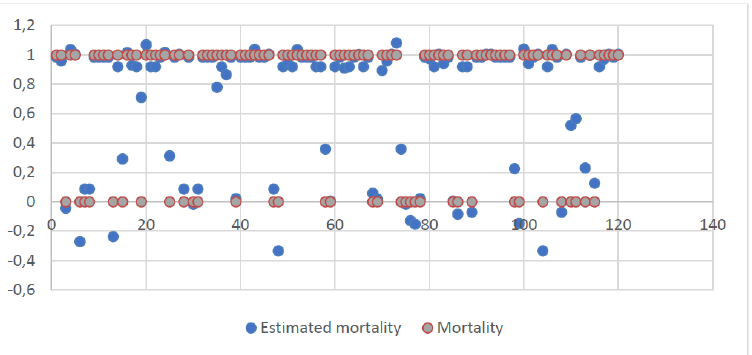
Figure 1. Results of linear regression between frailty criteria at recovery and after 2 years, and type of surgery, with estimated mortality.